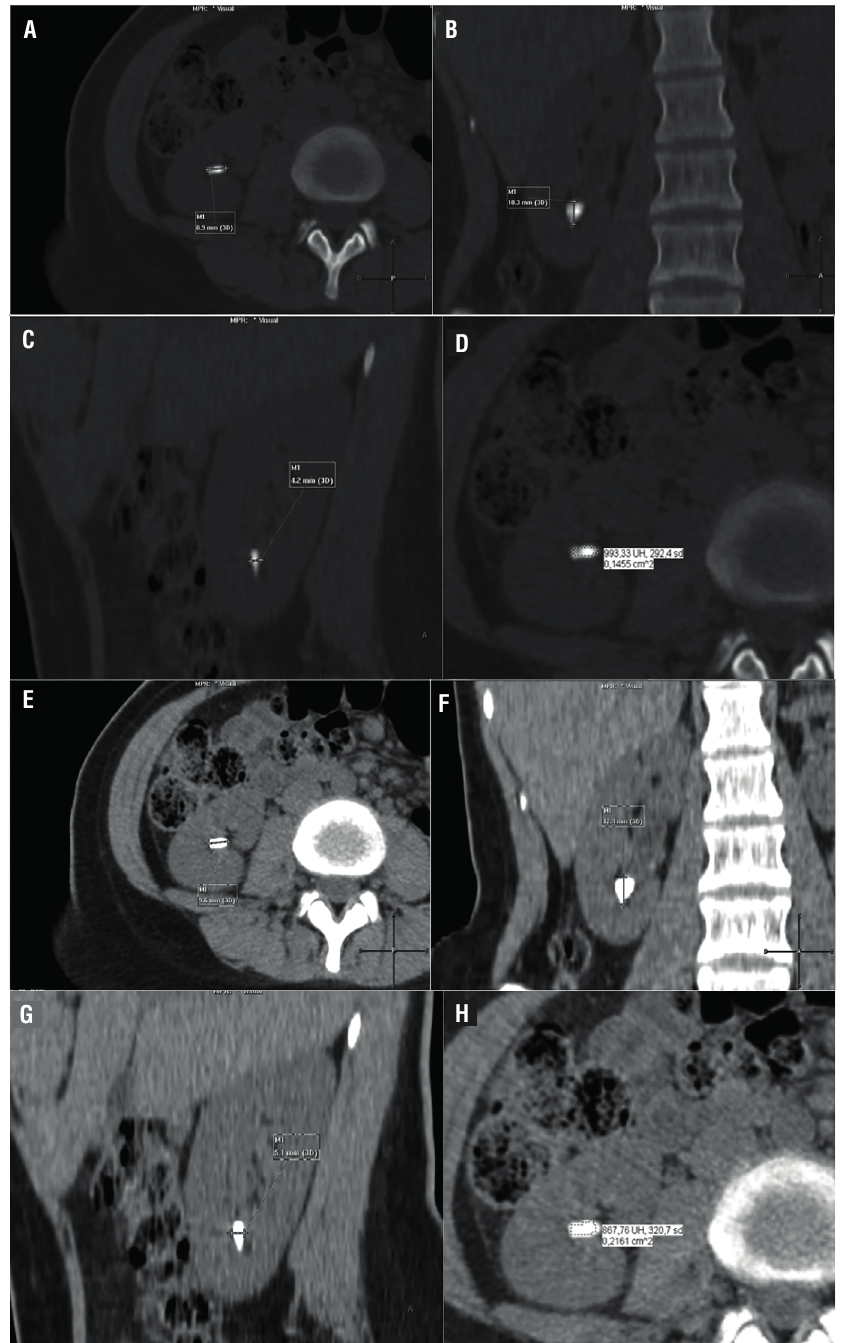
Figure 1 - Preoperative magnified (400%) NCCT bone window (ww 1600HU/wl 500HU) vs. soft tissue window (ww 400HU/ wl 40HU). A) bone window axial stone diameter, B) bone window coronal stone diameter, C) bone window sagittal stone diameter, D) bone window stone density, E) soft tissue window axial stone diameter, F) soft tissue window coronal stone diameter, G) soft tissue window sagittal diameter, H) soft tissue window stone